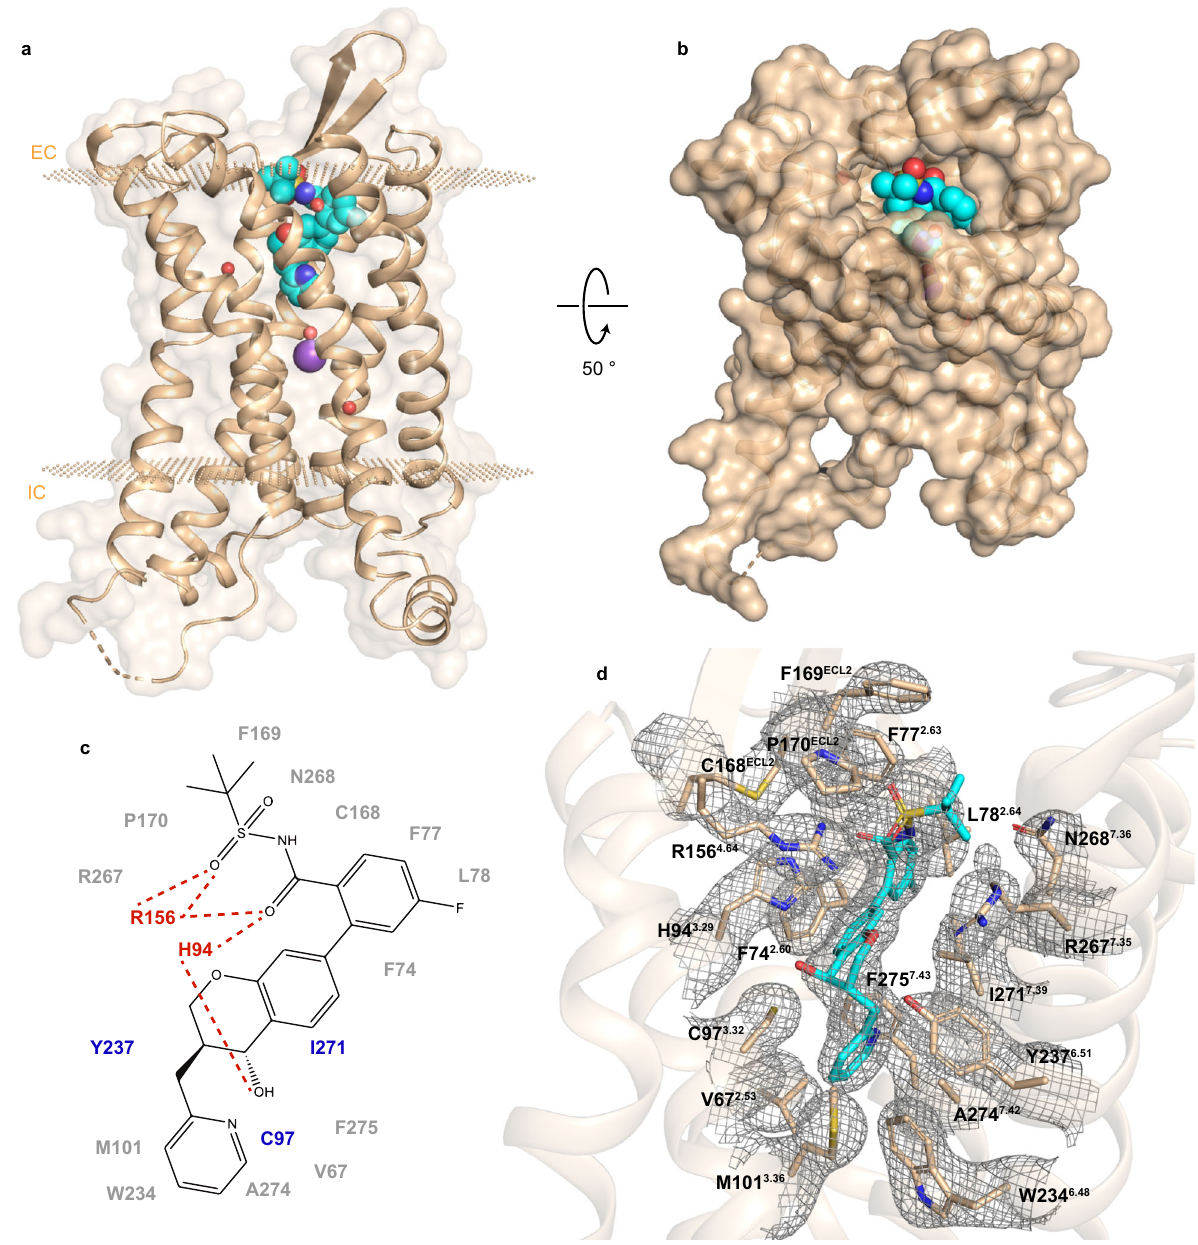
Fig. 1 Structure and binding site of hBLT1. a Structure of hBLT1 (wheat cartoon) in complex with MK-D-046 (spheres with cyan carbons). Small spheres (wheat) indicate membrane boundaries (EC, extracellular side; IC, intracellular side), as obtained from the Orientations of Proteins in Membranes (OPM) database 66 . Sodium (Na + , purple) and water (red) are shown as spheres. b Extracellular view of hBLT1 showing the solvent-exposed orthosteric binding pocket. c Chemical structure of MK-D-046 showing ligand-interacting residues within 4 Å. Critical residues evaluated in our functional and/or binding studies are colored red (polar interactions) or blue (hydrophobic interactions). Hydrogen bonds are shown as dashed red lines. d Re fi ned 2mF o -DF c electron density (gray mesh), contoured at 1.0 σ , around MK-D-046 and ligand-interacting residues within 4 Å from equivalent and tested them using IP 1 production assays. While an S264 7.32 R mutation had little effect on MK-D-046 potency, the three other mutations decreased potency by ~2-fold (Table 1 and (Fig. 3f). Out of the four orthologs, hBLT1 is the only one that Supplementary Fig. 2e). The ef fi cacy of MK-D-046 inhibition does not have a large and positively charged amino acid, R or K, remained similar for most mutations except for P170 ECL2 A, which reduced ef fi cacy by ~30%. When combined, all four at position 7.32 (Fig. 3a). The conformation of R263 7.32 in the gpBLT1 structure (PDB ID 5X33) overlaps with the position of mutations slightly reduced LTB4 potency, while their effects on MK-D-046 in the hBLT1 structure (Fig. 3f), indicating that MK- MK-D-046 and BIIL-260 potencies remained moderate (Table 1 D-046 and other similar ligands may have reduced binding at and Supplementary Table 4, Supplementary Figs. 1e and 2e, f). gpBLT1, as well as mBLT1 and rBLT1. We mutated each of the These results are, however, in stark contrast with a slightly four non-conserved residues in hBLT1 to their gpBLT1 increased potency of LTB4, an ~15-fold decreased potency of